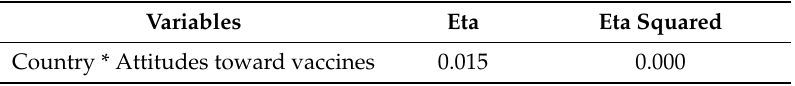
Symbol * represents the combination of two